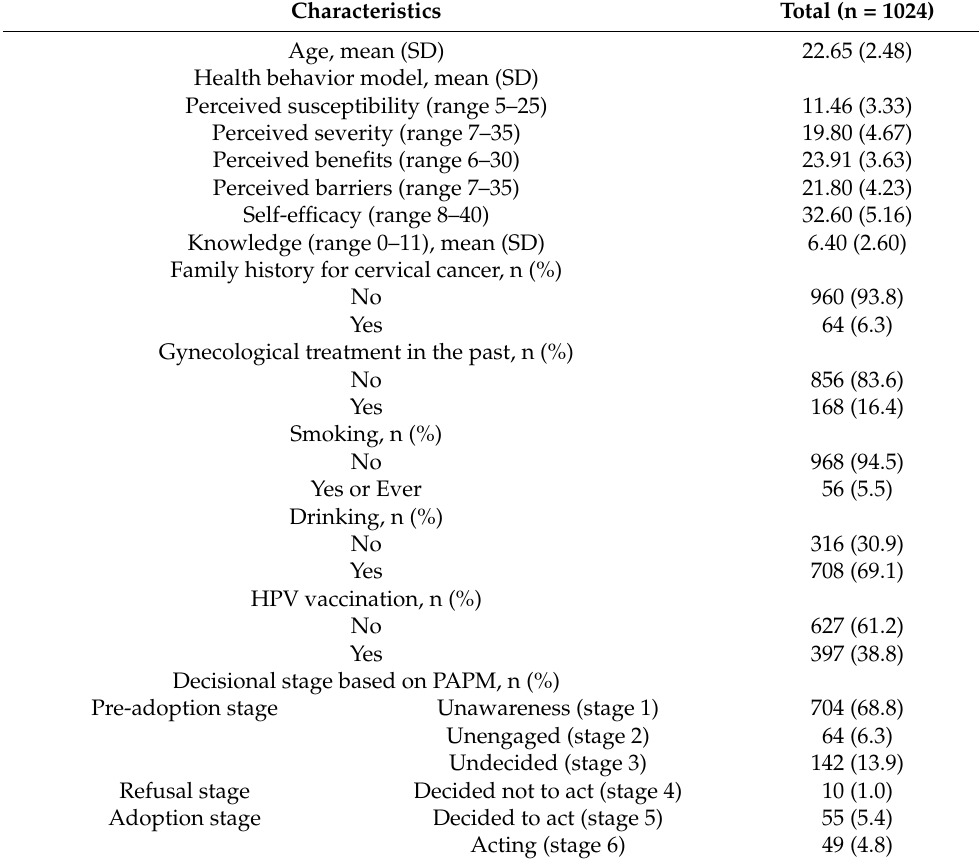
Table 1. General characteristics of